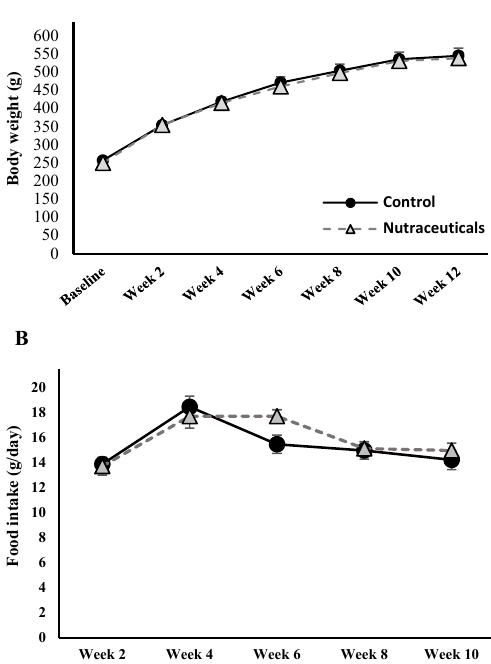
Figure 1. ( A ) Body weight of high-fat/high-fructose-fed rats in both study groups; ( B ) food intake was measured in one day every second week from week 2 to 10, and presented as g/day. No significant difference was found between groups (error bars: standard error of the mean). Nutraceuticals combination consisted of caffeic acid, trigonelline, and